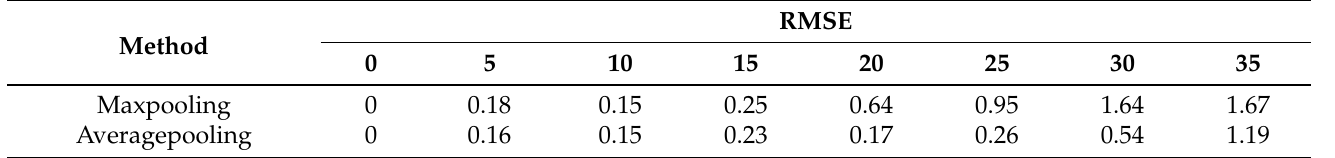
Table 3. RMSE for two pooling